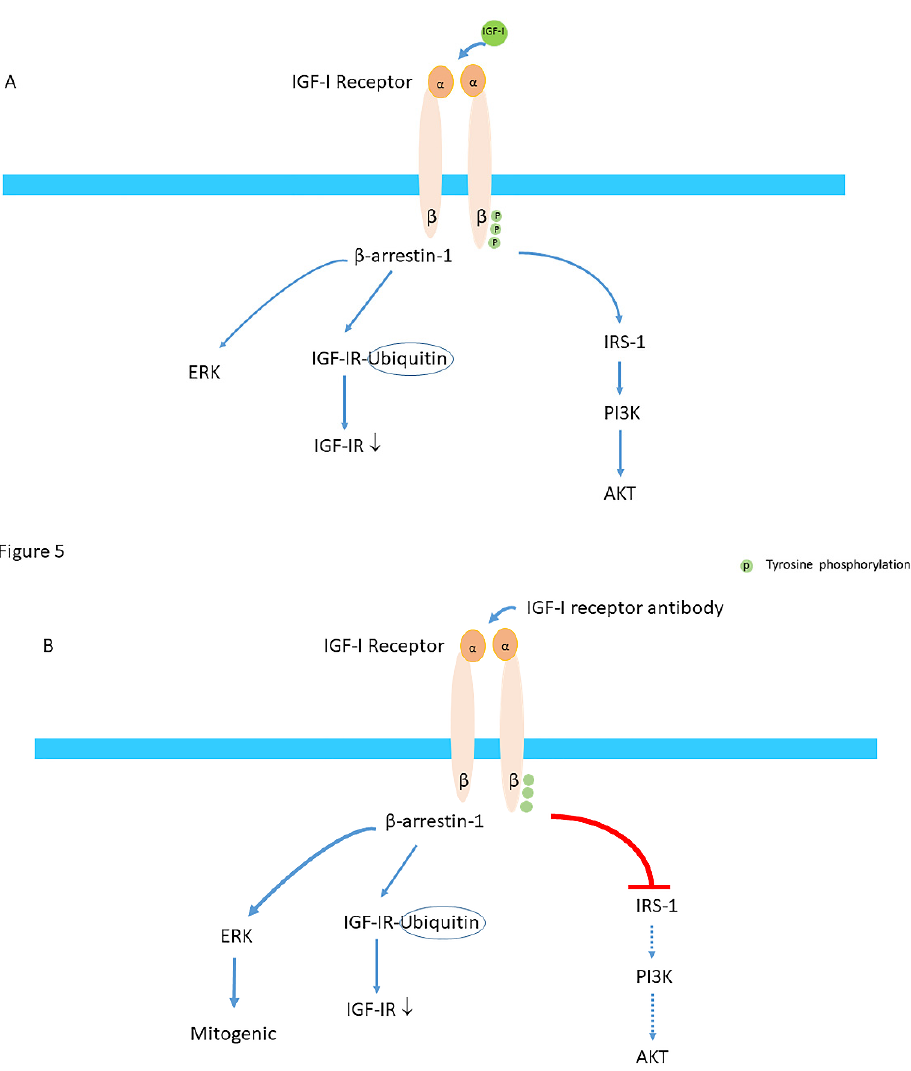
Figure 5. ( A ) Mechanisms of balanced agonism; activation of the IGF-IR stimulates not only the AKT pathway by phosphorylation of IRS-I and PI3K, but in addition, stimulates the β -arrestin-1 ( β -arr1) pathway which leads to proteasomal degradation of the IGF-IR through an ubiquitin (Ub)-mediated mechanism and ERK activation. ( B ) Beta-arrestin-1 biased agonism. Binding of monoclonal (blocking) antibodies directed against the IGF-IR block the kinase cascade pathway (by blocking phosphorylation of IRS-1, PI3K and AKT) but simultaneously activate the β -arrestin-1 ( β -arr1) pathway which induces enhanced IGF-IR receptor internalization (ubiquitination) and activation of ERK signaling pathway. (Modified from Salisbury & Tomblin. Insulin / Insulin-like growth factors in cancer: new roles for the aryl hydrocarbon receptor, tumor resistance mechanisms, and new blocking strategies. Front Endocrinol (Lausanne), 2015; 6:12).